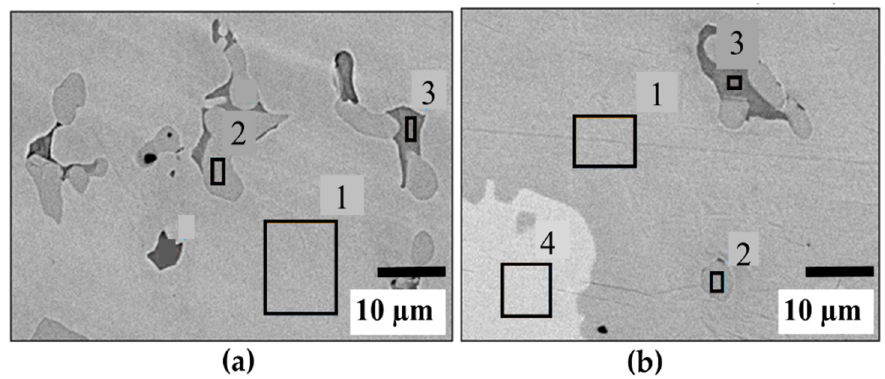
Figure 2. EDX analysis of TiFe with the addition of V only ( a ) 2 wt.% V; ( b ) 4 wt.% V. Table 2. Chemical composition of each phase present in alloys with V only (uncertainty on all values is ±1). Alloys Ti (at.%) Fe (at.%) V (at.%) TiFe + 2 wt.% V